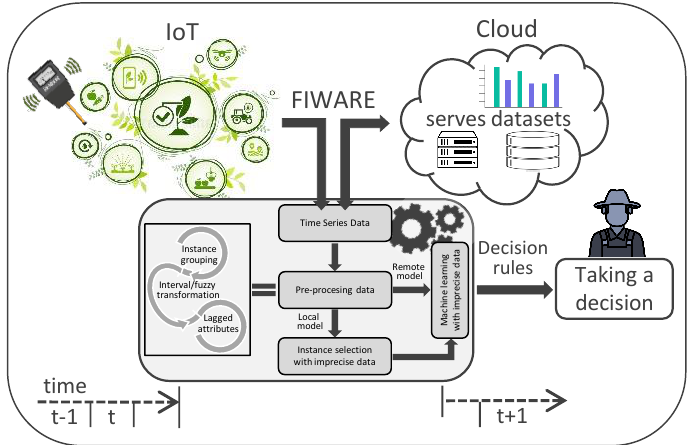
Figure 1. Proposed methodology embedded within an IoT ecosystem.